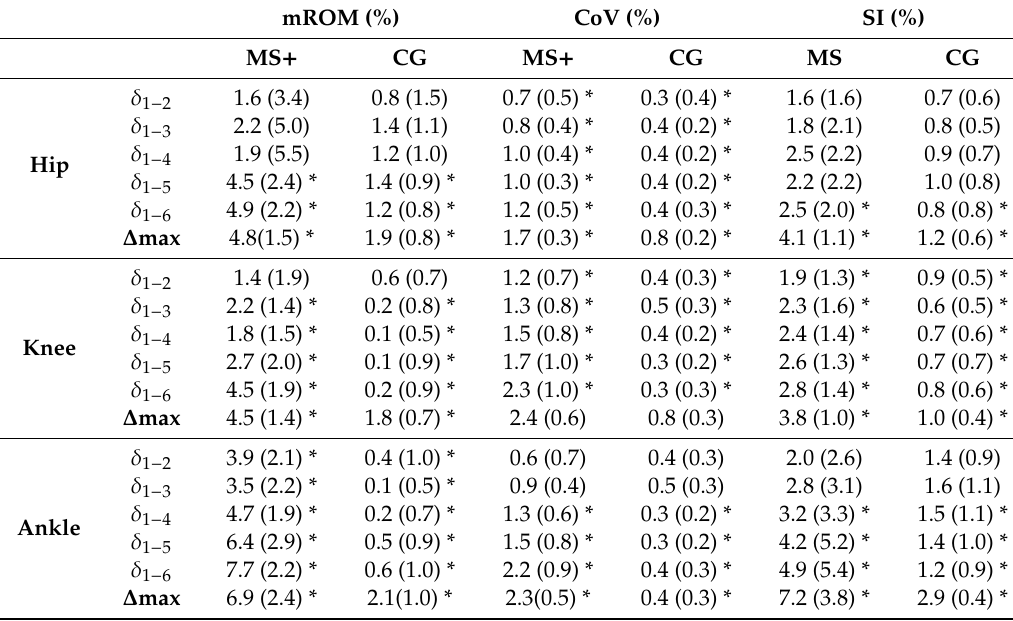
Table 6. Mean (standard deviation) related to the δ r for the ROM and δ CoV and SI index. MS + and control group (CG) represent the most variable side of patients and the control group, respectively. mROM